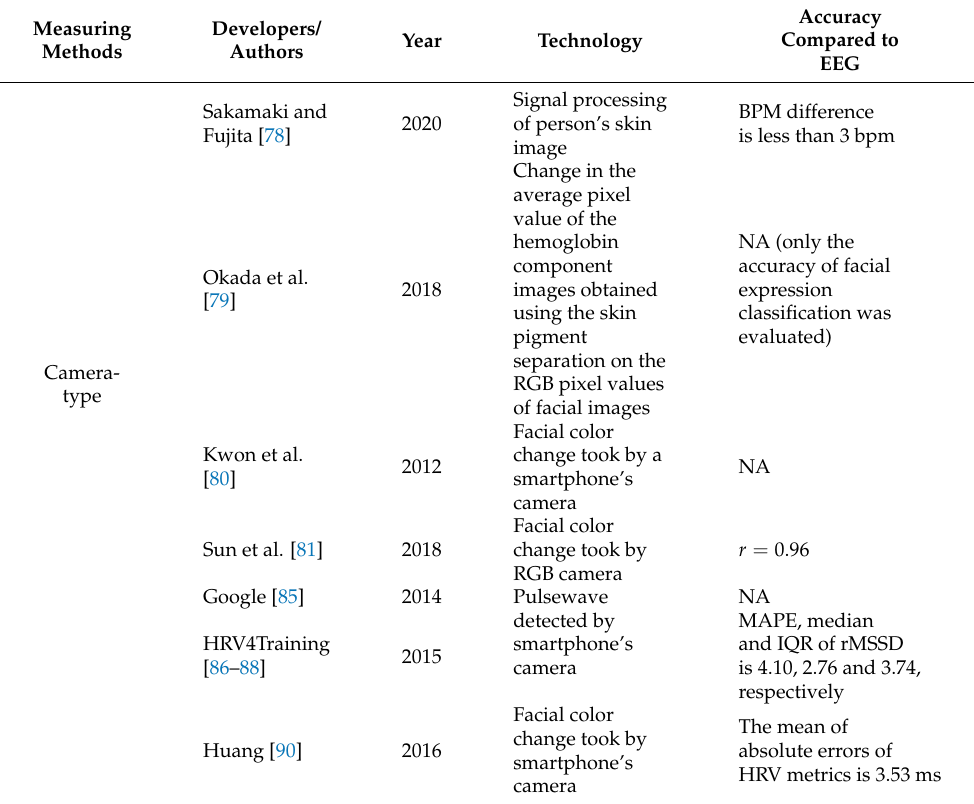
Table 5. Comparison table of nonwearable-type heartbeat measuring methods in this review (contin- ued). NA means that no description of accuracy can be found.